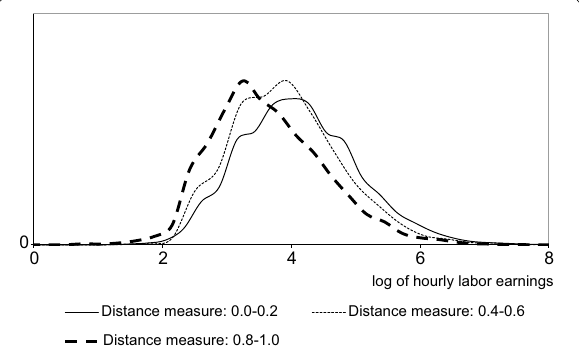
Fig. 2 Kernel density estimates of hourly labor earnings among mismatched workers by intervals of the distance measure. The sample comprises employed individuals with a bachelor’s degree, aged between 25 and 60 years, classified as mismatched. Source: